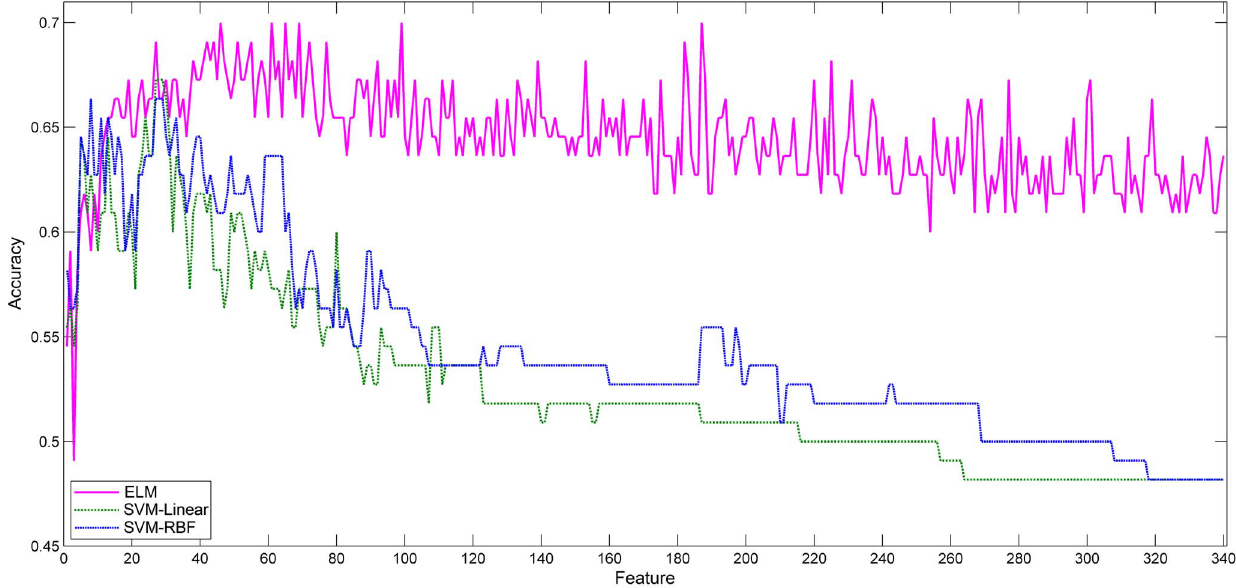
Figure 2. Comparison of the testing accuracy of ELM, SVM-Linear and SVM-RBF in ADHD classification based on F-score feature selection.